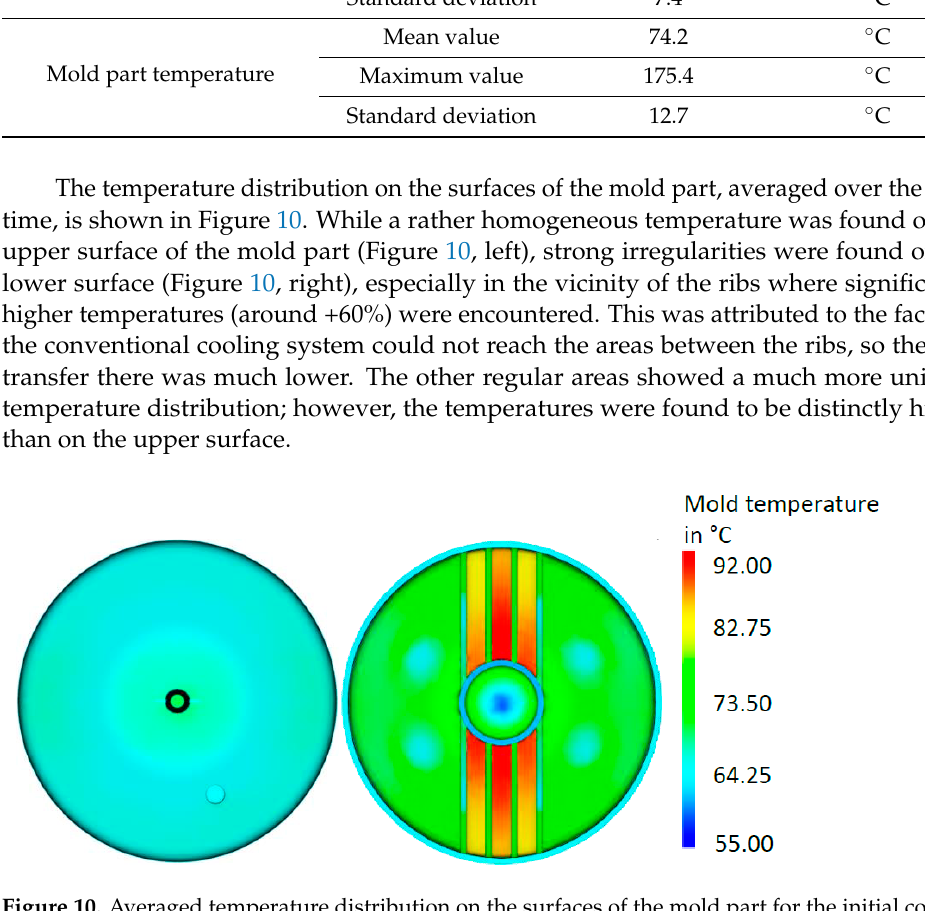
Figure 10. Averaged temperature distribution on the surfaces of the mold part for the initial configu- ration: Upper surface ( left ), lower surface ( right